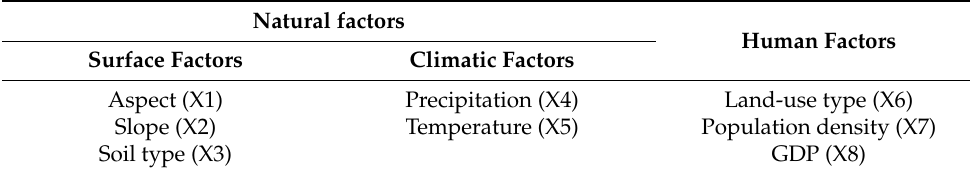
Table 2. Indicators of natural and human